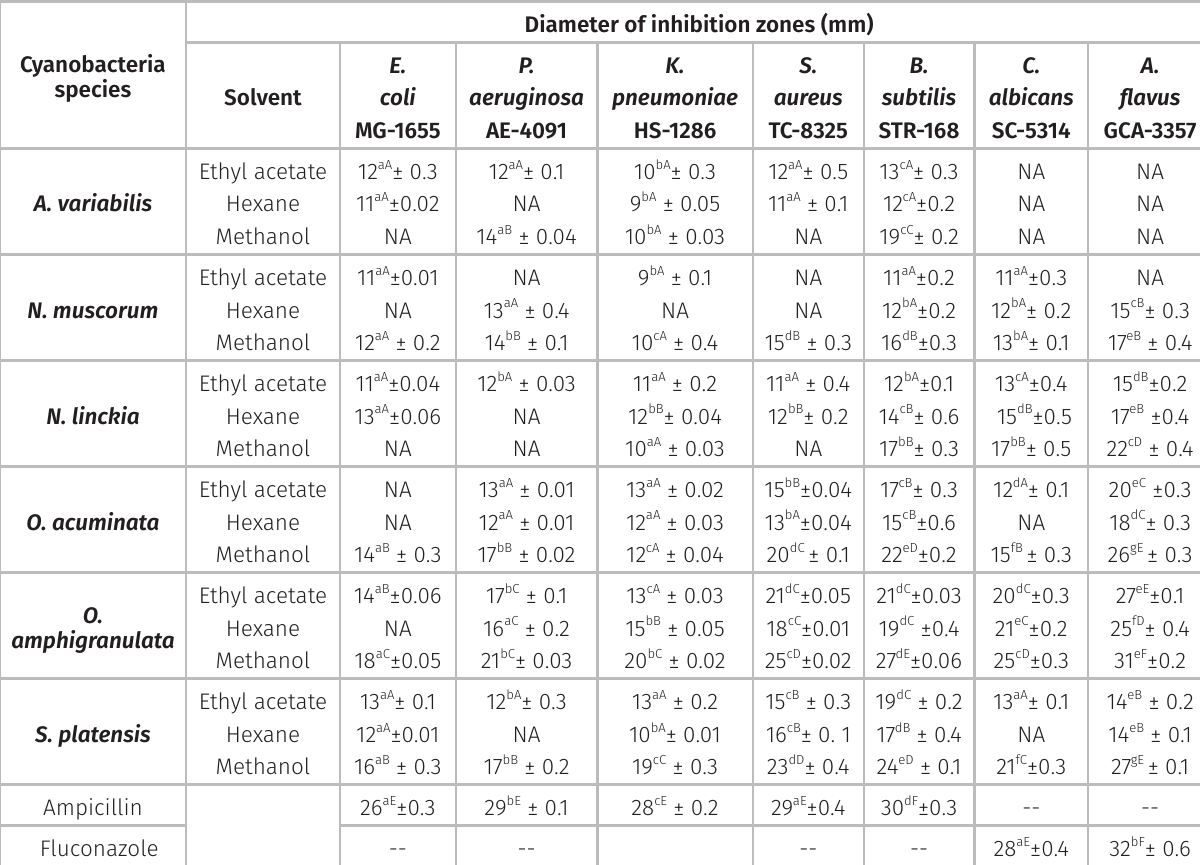
Table I. Antimicrobial activity of cyanobacterial extracts using different solvents (mean± SD).